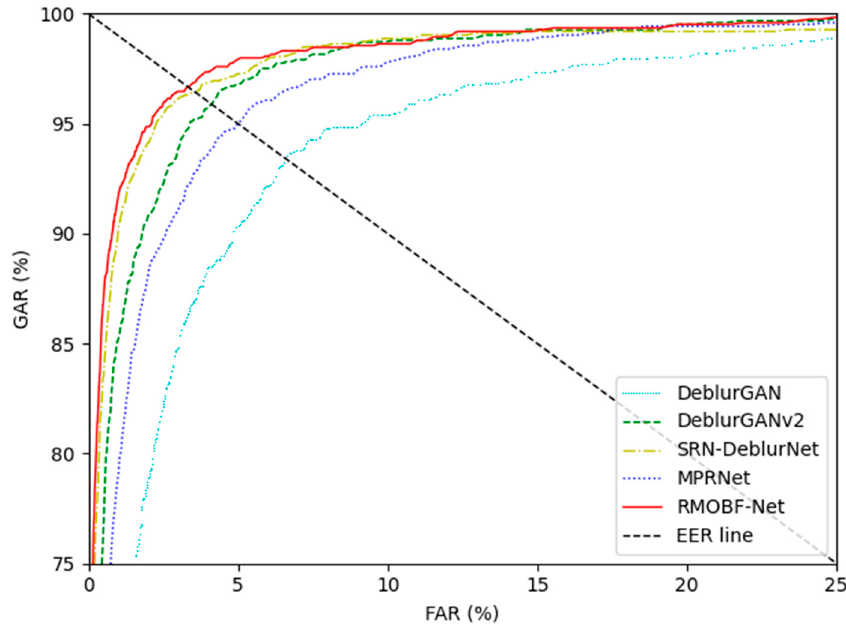
Figure 32. ROC curves of finger-vein recognition with PolyU-DB for scheme 4 by various restoration methods (random motion blur and optical blur with intensity 19 × 19 (Gaussian filter size) and 19 (Gaussian filter standard deviation)).